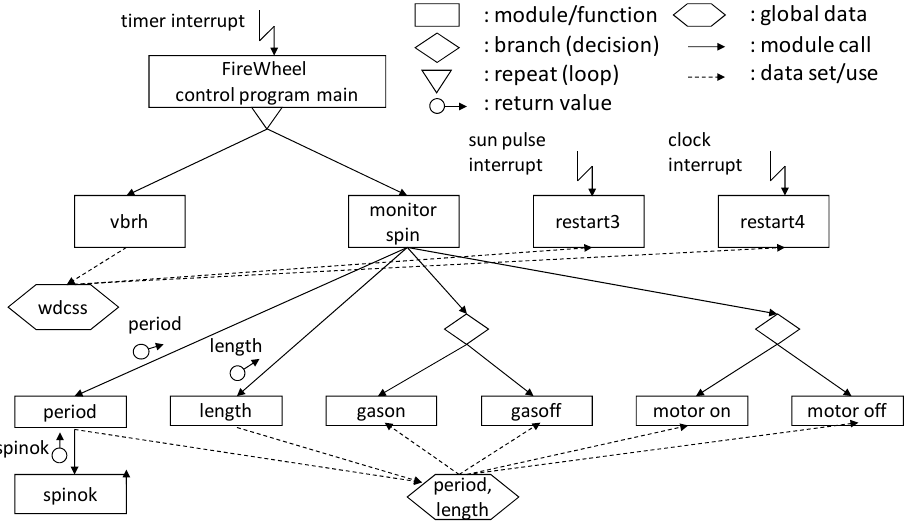
Figure 15. Outline of ECSW structure for spin stabilized satellite.